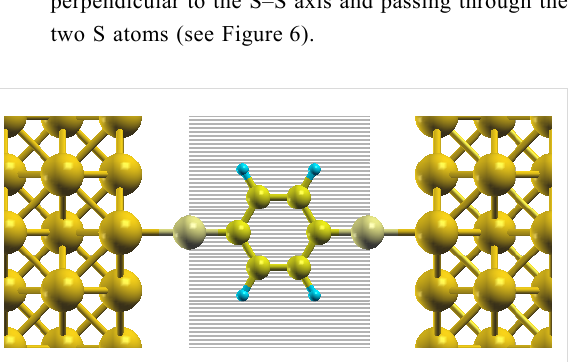
Figure 6: Scheme representing the integration volume (shadowed area passing through the two S atoms of the BDT-h junction) used for Method